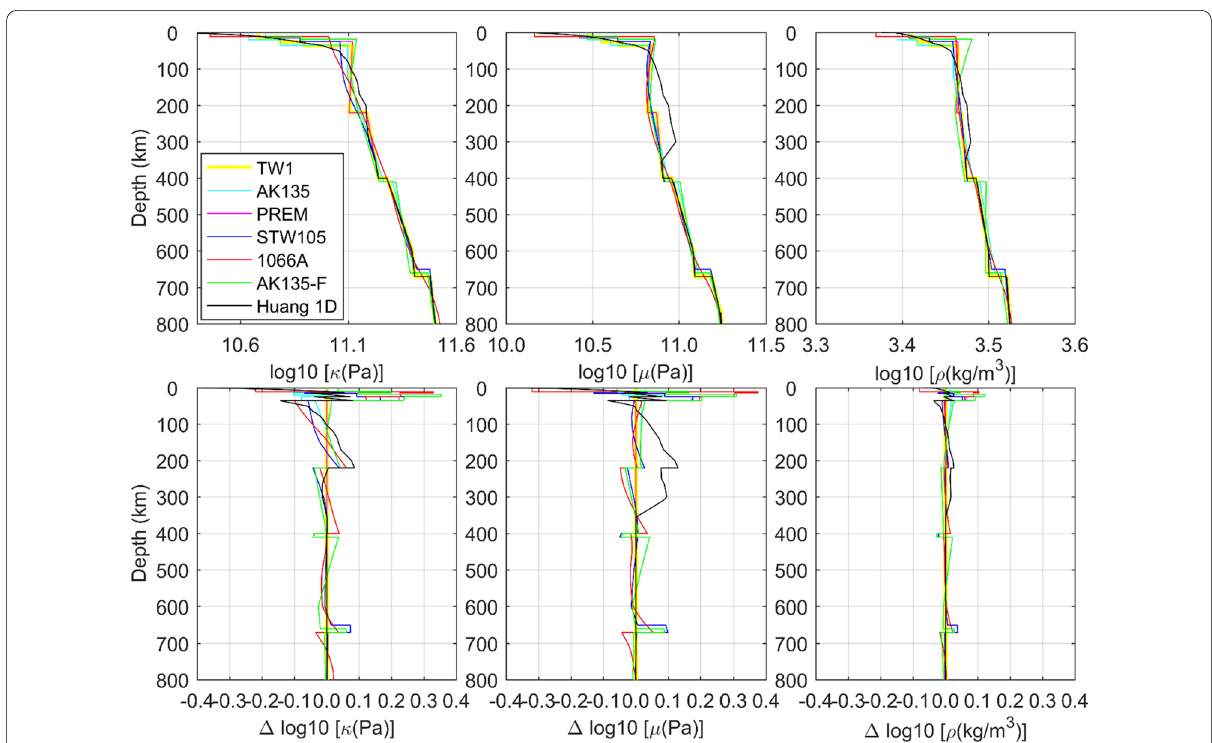
Fig. 9 Profiles of six Earth models and the corresponding deviation values to TW1. The top three patterns are the exact values in TW1 (yellow), AK135 (cyan), PREM (magenta), STW105 (blue), 1066A (red), AK135-F (green), and Huang 1D (black), and the bottom three patterns are the deviation values to TW1. The left, middle, and right columns are the bulk modulus, shear modulus, and density, respectively, in log